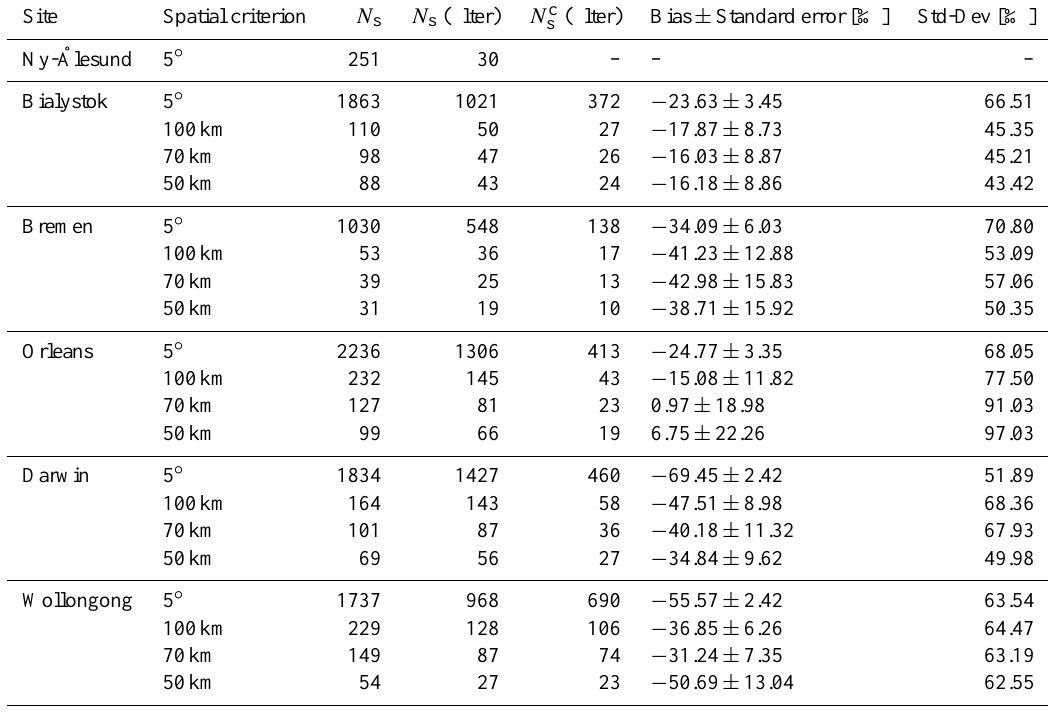
Fig. 5. Spectral fit of the TCCON HDO (top panel) and H 2 O (bot- tom panel) retrieval at Orleans, France on 31 July 2010. The hori- zontal lines indicate the boundary of the fit windows given in Table 1.